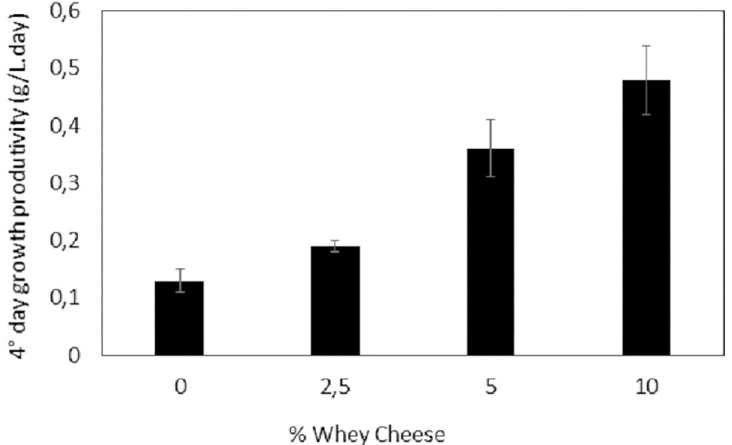
Fig 2. Productivity of S . platensis grown on autotrophic Zarrouk medium and mixotrophic medium supplemented with buffalo mozzarella cheese whey on the 4 th day of growth. The error bars represent the standard deviations (n = 3).